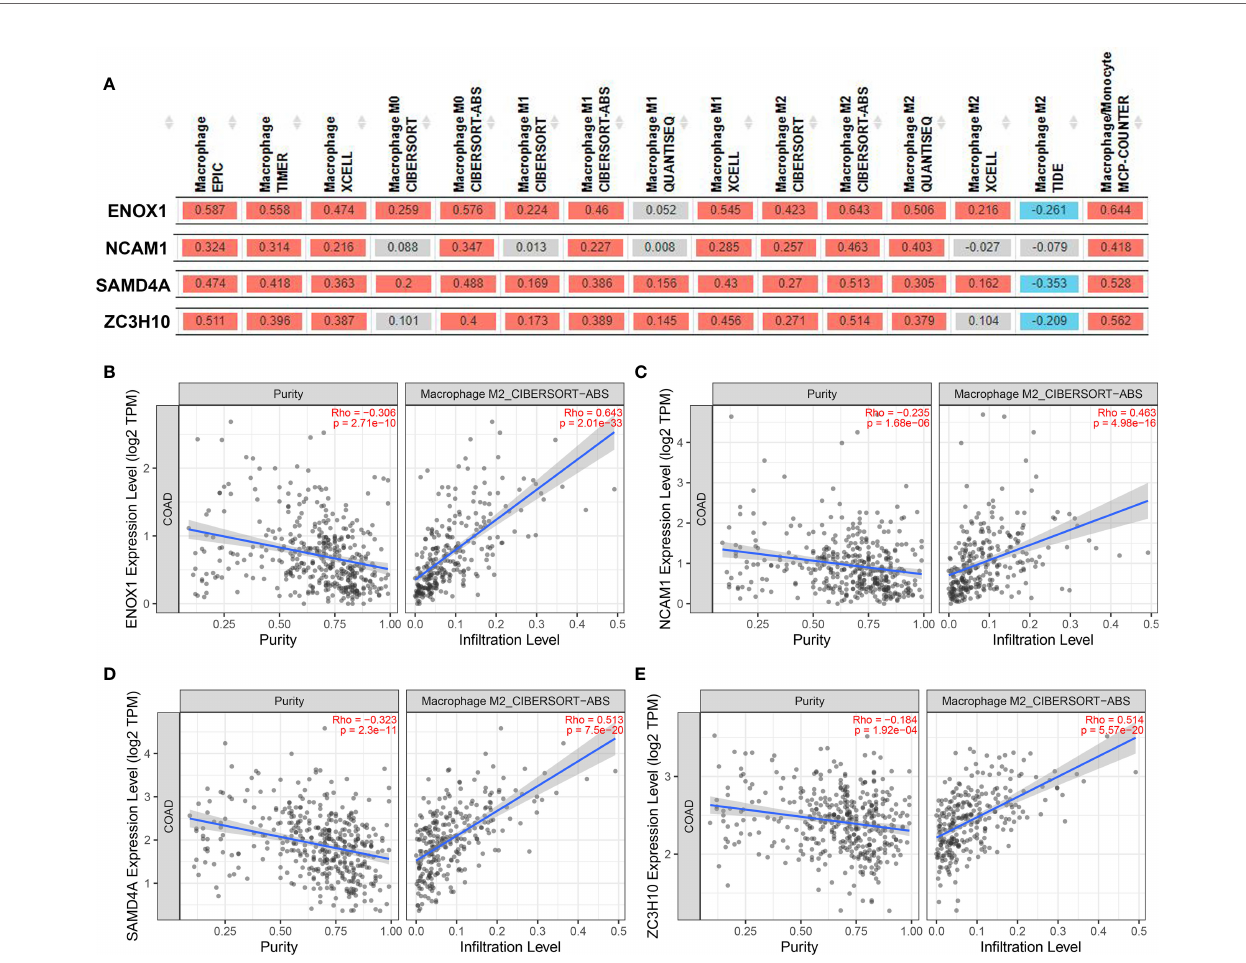
FIGURE 11 | Correlation between targeted gene expression levels and the in fi ltration level of macrophage cells. The XCELL, TIMER, CIBERSORT, CIBERSORT- ABS, QUANTISEQ, MCP-COUNTER, and EPIC algorithms were applied for immune in fi ltration estimations with ENOX1, NCAM1, SAMD4A, and ZC3H10. (A) Overview of the correlations between ENOX1, NCAM1, SAMD4A, and ZC3H10 and the macrophages. The CIBERSORT-ABS algorithm was used to estimate the correlations between ENOX1, NCAM1, SAMD4A, and ZC3H10 and the M2 macrophages after tumour purity adjusting in panels (B – E) . (B) ENOX1 and M2 macrophages, (C) NCAM1 and M2 macrophages, (D) SAMD4A and M2 macrophages, (E) ZC3H10 and M2